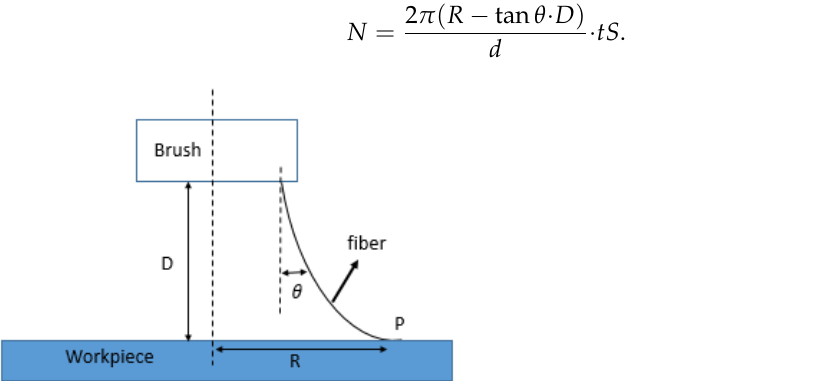
Figure 4. Schematic of the lapping process. One fiber on the brush is swept from the workpiece surface. The wear model for the nodes in this simulation was built based on the Archard model.